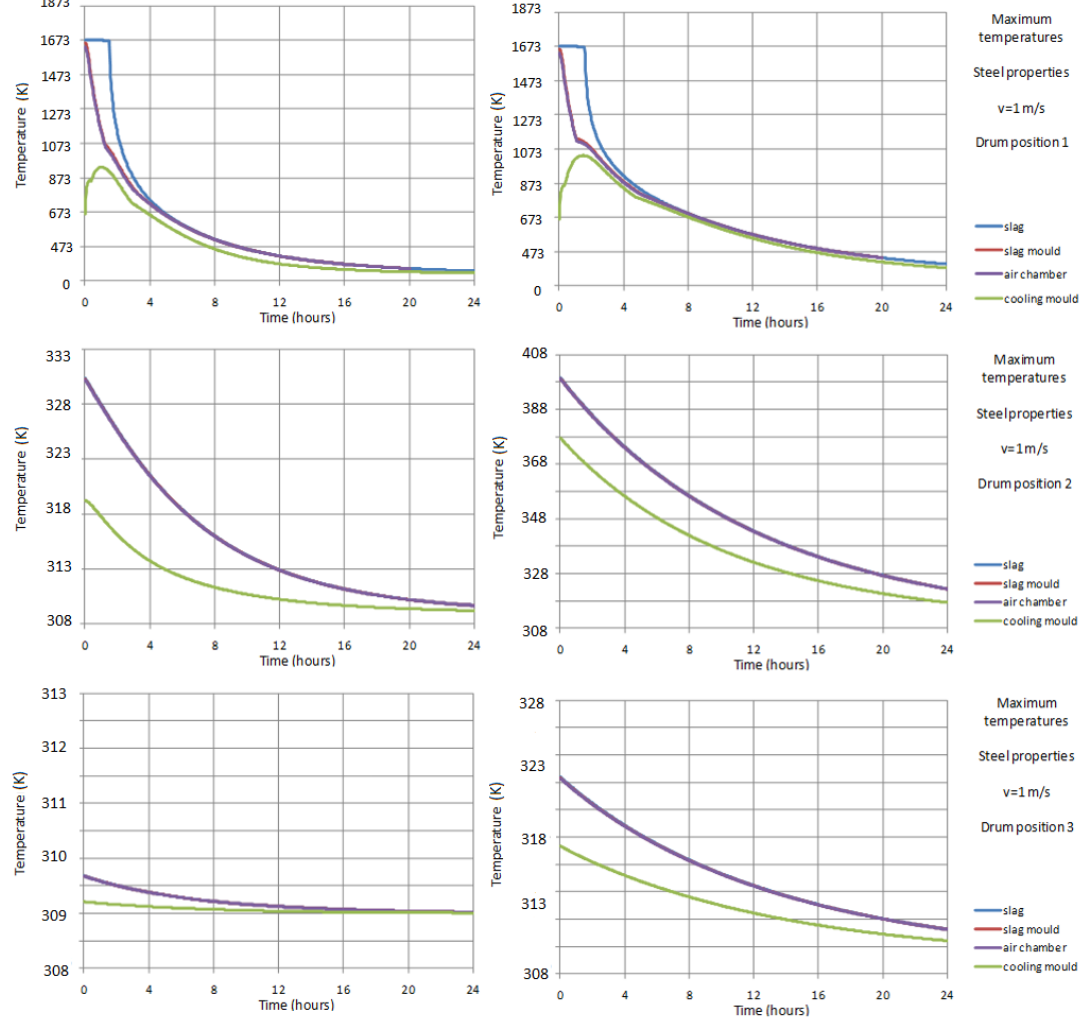
Figure 4. ( Left ) Maximum temperatures during the cooling process (steel properties, v = 3 m/s) for drum 1 ( top ), drum 2 ( middle ), and drum 3 ( bottom ). ( Right ) Maximum temperatures during the cooling process (steel properties, v = 1 m/s) for drum 1 ( top ), drum 2 ( middle ), and drum 3 ( bottom ).